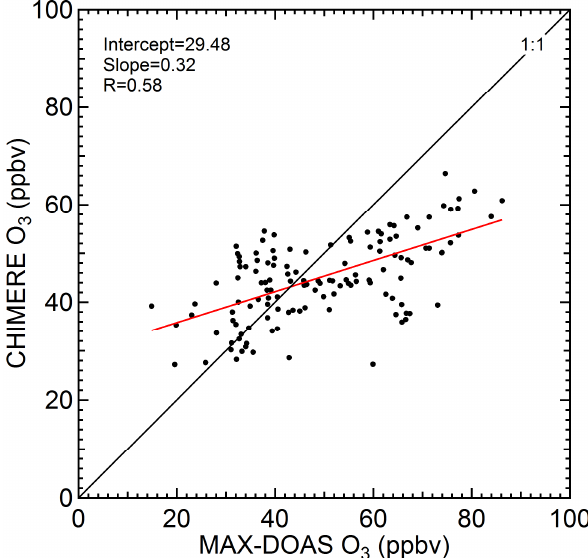
Fig. 16. Correlations between O 3 VMRs from MAX-DOAS and CHIMERE. The linear least-squares fit taking into account error ranges of MAX-DOAS data is shown with the red line.